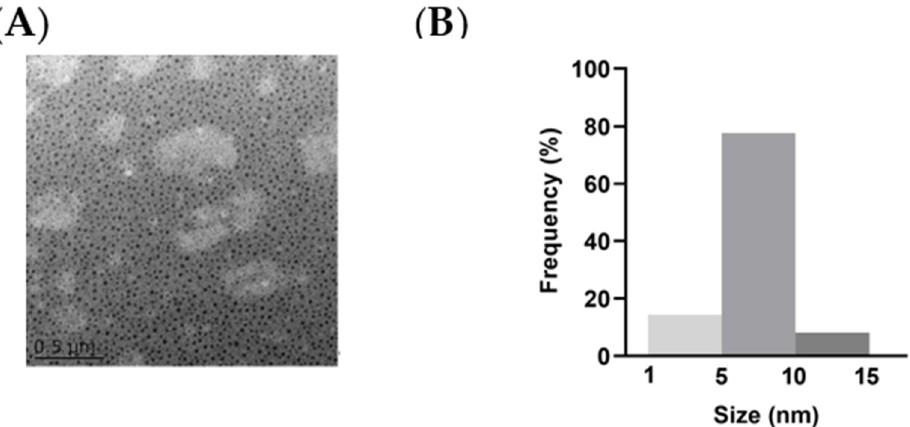
Figure 1. Characterizations of NCDs. ( A ) Morphology of NCDs in TEM measurement. ( B ) Size distribution of NCDs.